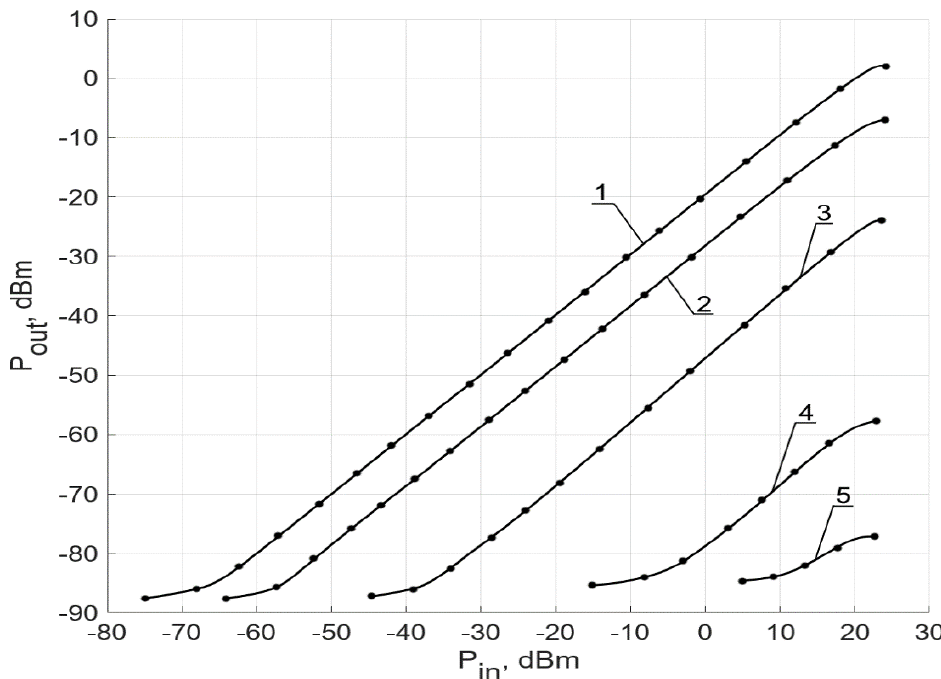
Figure 5. Amplitude characteristic of FOCL. Graphs 1, 2, 3, 4, and 5 correspond to L in km: 100; 150; 250; 400; and 500.